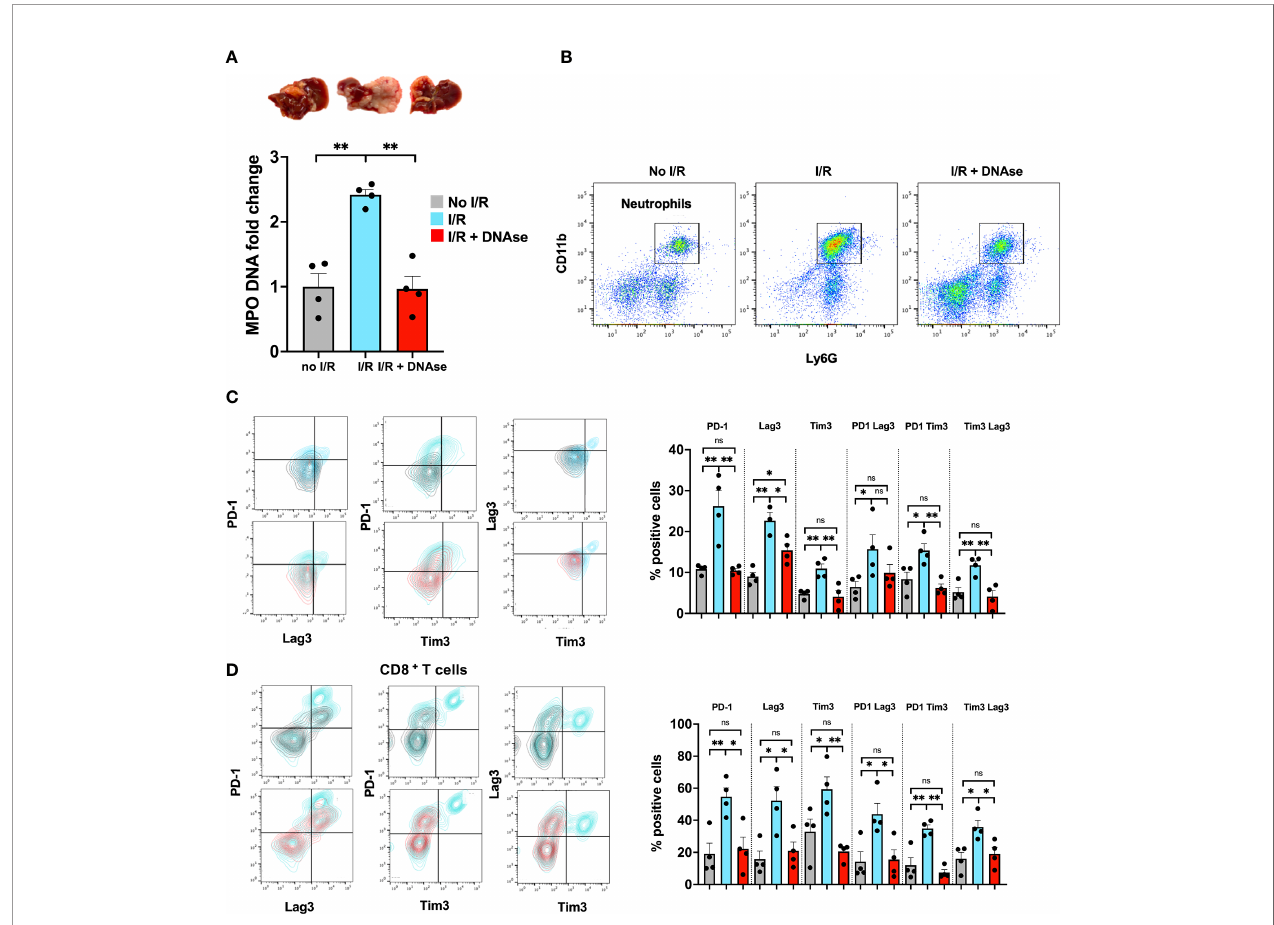
FIGURE 1 | T cells in a NET-rich environment exhibit a phenotype of T cell exhaustion. Mice underwent tumor inoculation followed by liver I/R on day 6 or sham treatment. Animals treated with DNAse received daily injection until tumor harvest 3 weeks later. (A) Animals that underwent I/R had elevated serum MPO-DNA levels and massive tumors. Sham mice (no I/R) and I/R mice treated with DNAse had normal levels of MPO-DNA and smaller tumors. (B) Similarly, higher levels of Neutrophils were found in the TME of I/R animals. (C, D) T cells within the TME of mice that underwent I/R express higher levels of markers for T cell exhaustion including PD1, LAG3, Tim3 and double positive markers compared to sham animals. T cell exhaustion is reversed to baseline in animals that underwent I/R and were treated with DNAse. Representative fl ow plots for double stained cells are shown. Bar graphs represent the mean +/- SEM of three individual experiments performed in duplicates or triplicates; *p < 0.05/**p <